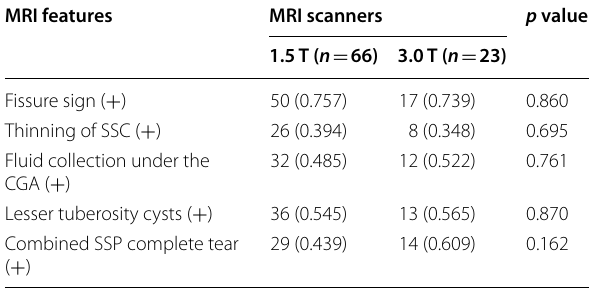
Table 5 Results of the associated MRI features that